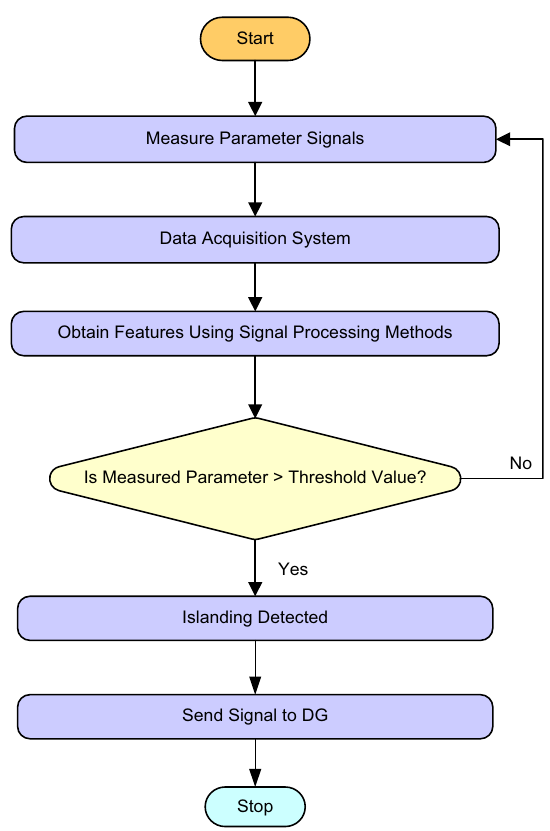
Fig. 7 Algorithm for signal processing-based islanding detection method